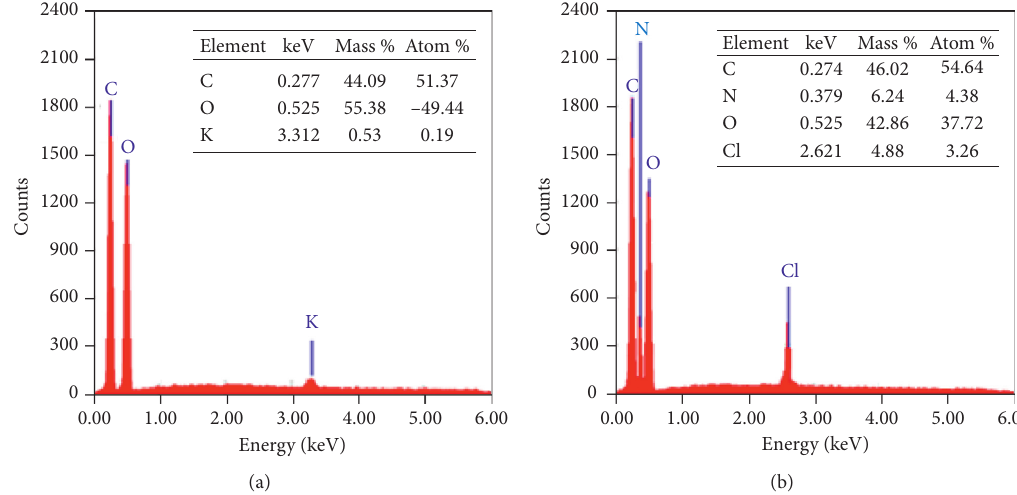
Figure 6: EDX spectra of (a) bare cotton fibers and (b) polyaniline-deposited cotton